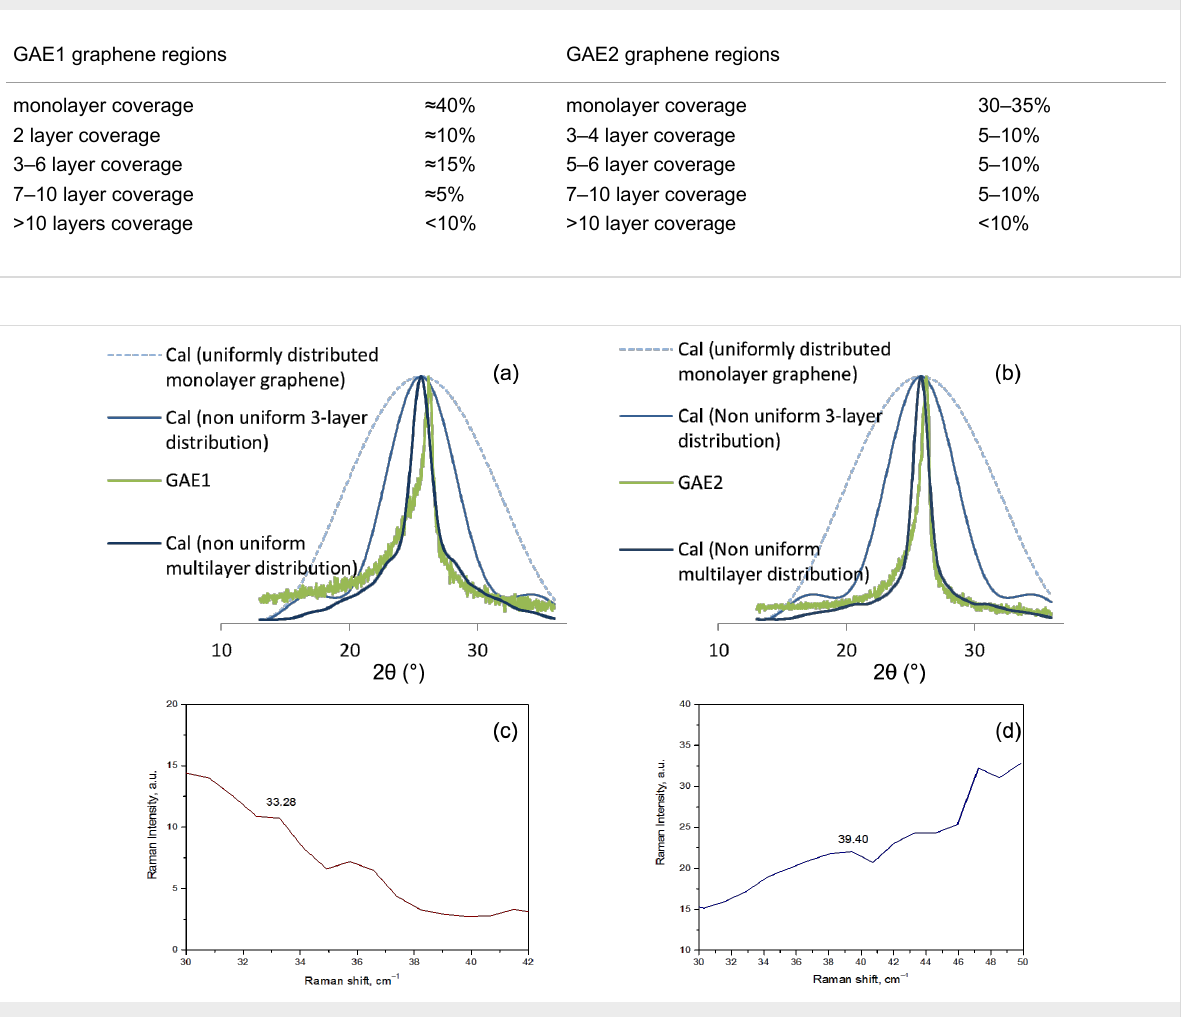
Figure 7: (a) Nonuniform multilayer distribution curve for sample GAE1 from Equation 1 [12]; (b) nonuniform multilayer distribution curve for sample GAE2 from Equation 1; (c) C -peak position in Raman spectrum for graphene sample GAE1; (d) C -peak position in Raman spectrum for graphene sample